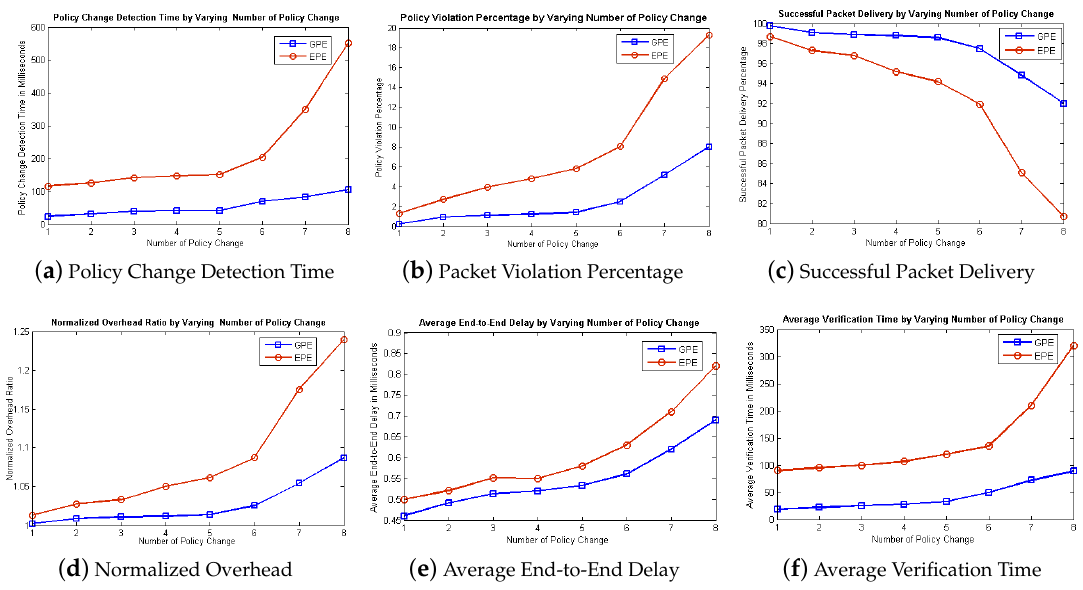
Figure 5. Simulation Results by Varying Number of Policy